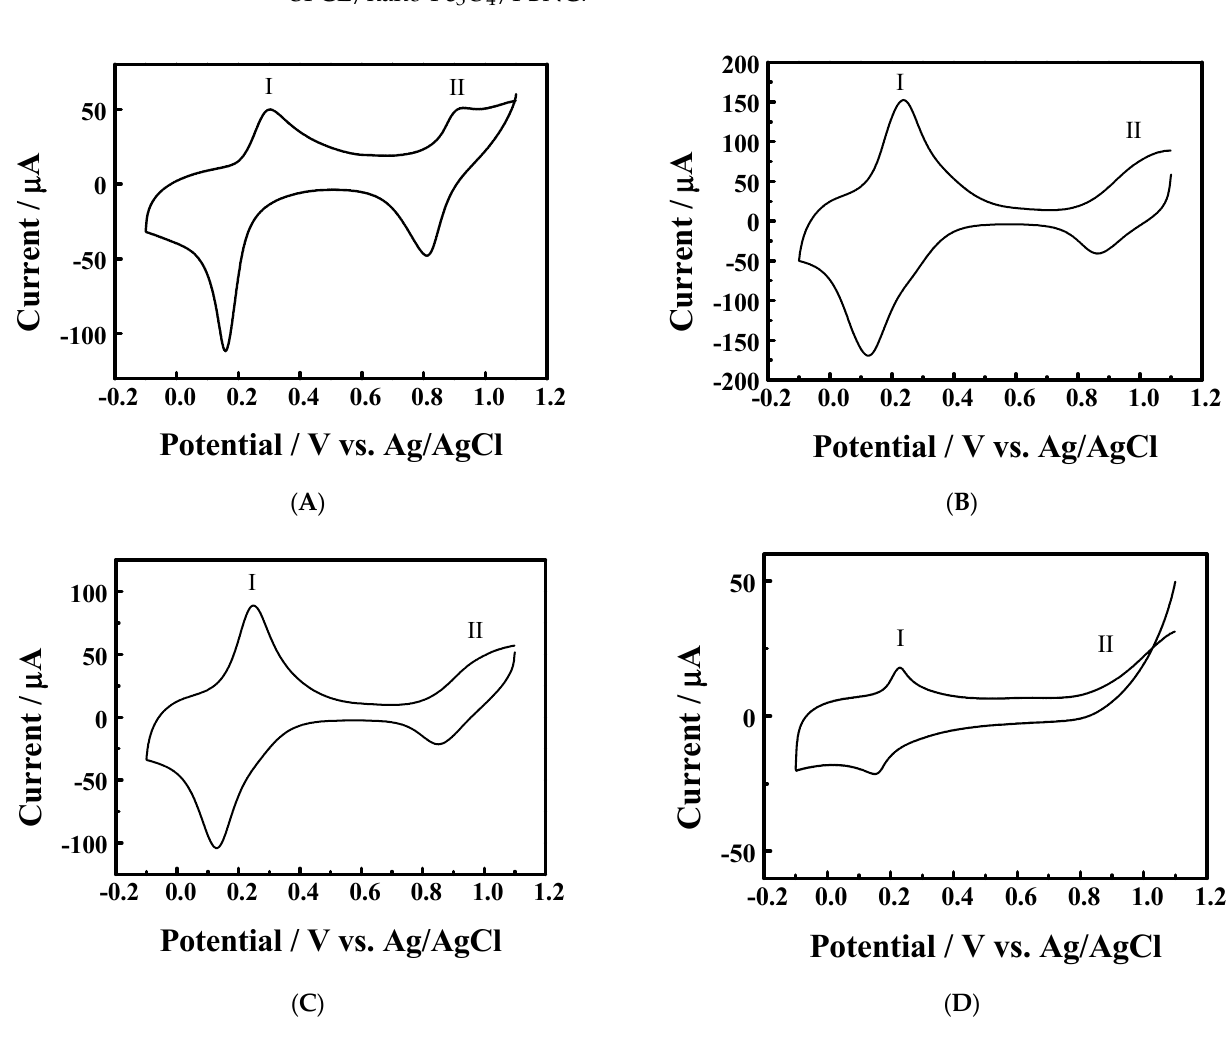
Figure 2. Cyclic voltammograms of the resultant Prussian blue modified electrode SPCE/nano − Fe 3 O 4 /PBNC obtained from ( A ) Solution I, ( B ) Solution II, ( C ) Solution III, and ( D ) Solution IV, and then transferring to 0.1 M KCl. Scan rate = 0.1 Vs − 1 .